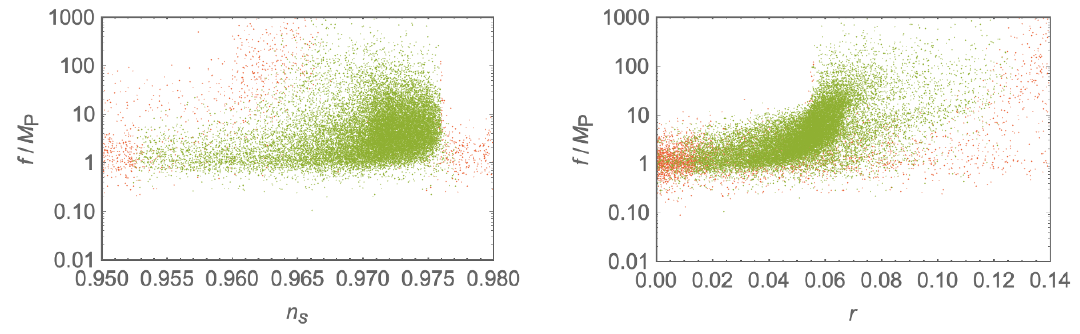
Figure 4 . Left panel: a plot of f=M P as a function of n s which is in the allowed range of experiment and N pivot in the range 50{60 for the same data set as in (cid:12)gure 1. Right panel: the same as the left panel except that the plot is of f=M P as a function of r . We note that there are experimentally consistent points with f=M P 2 [0 : 1 ;